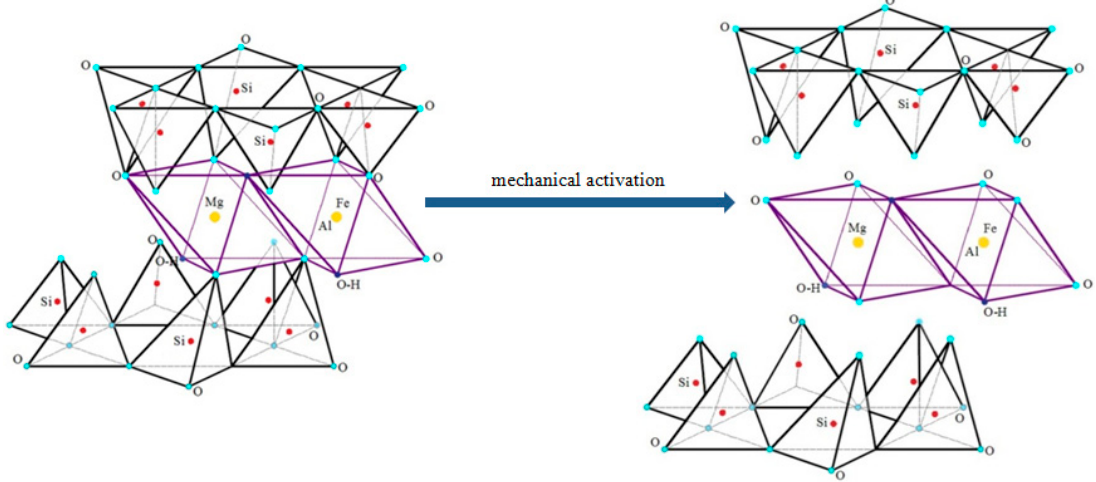
Figure 1. Crystal lattice of saponite before and after mechanical activation.